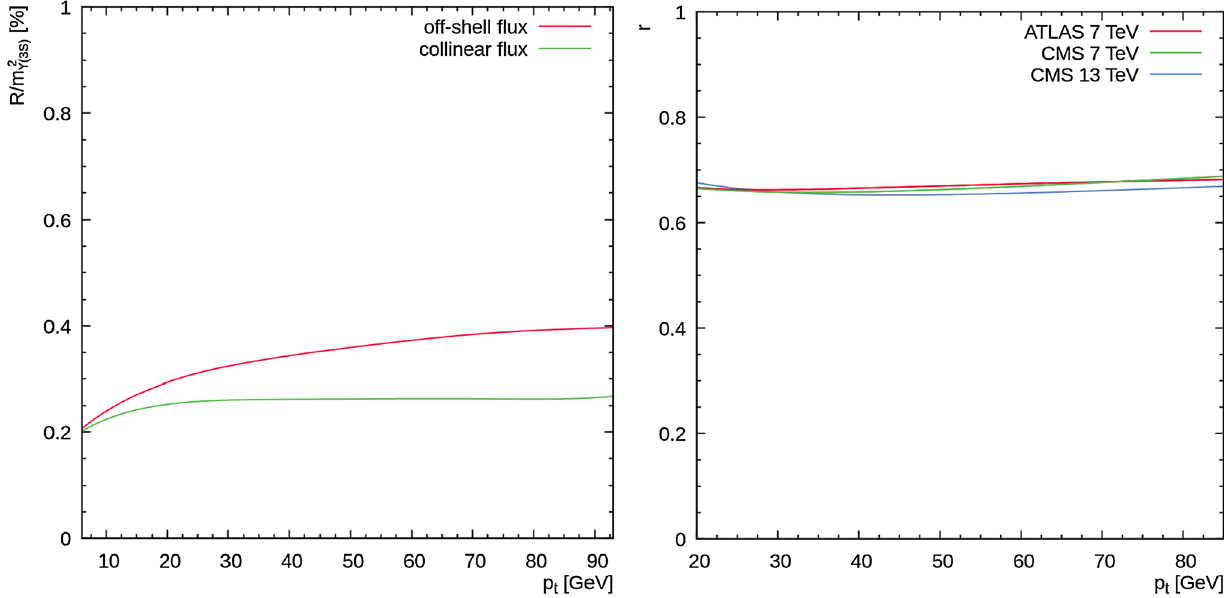
Fig. 2 The production ratios R (left panel) and r (right panel) calculated as a function of ϒ( 3 S ) transverse momentum p T in the different kinematical